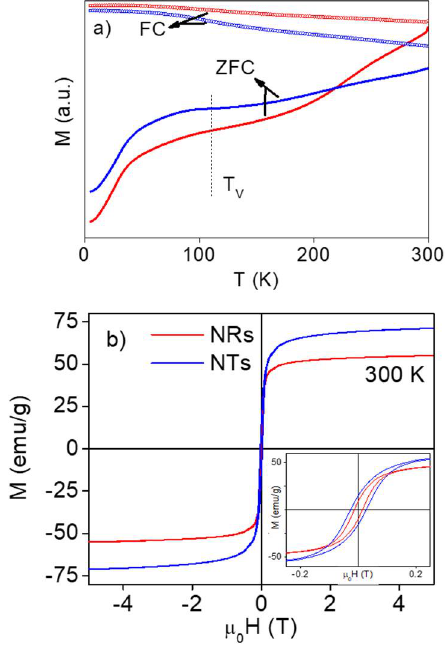
Figure 2. Magnetization measurements for the iron oxide NRs and NTs: ( a ) the ZFC/FC M-T curves measured at 50 Oe (the expected Verwey temperature is indicated by T V ); ( b ) the M-H loops measured at 300 K with a zoom into the low field region